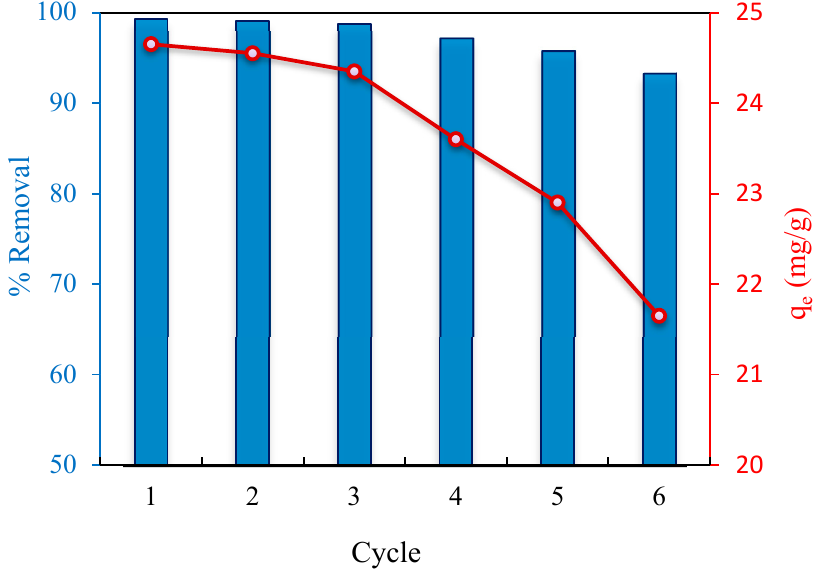
Figure 5. Reusability study of MWCNTs/CoFe 2 O 4 on LFX uptake (C 0 = 50 mg/L, temperature 30 ± 2 °C, dose = 1 g/L, time 90 min and pH = 5).